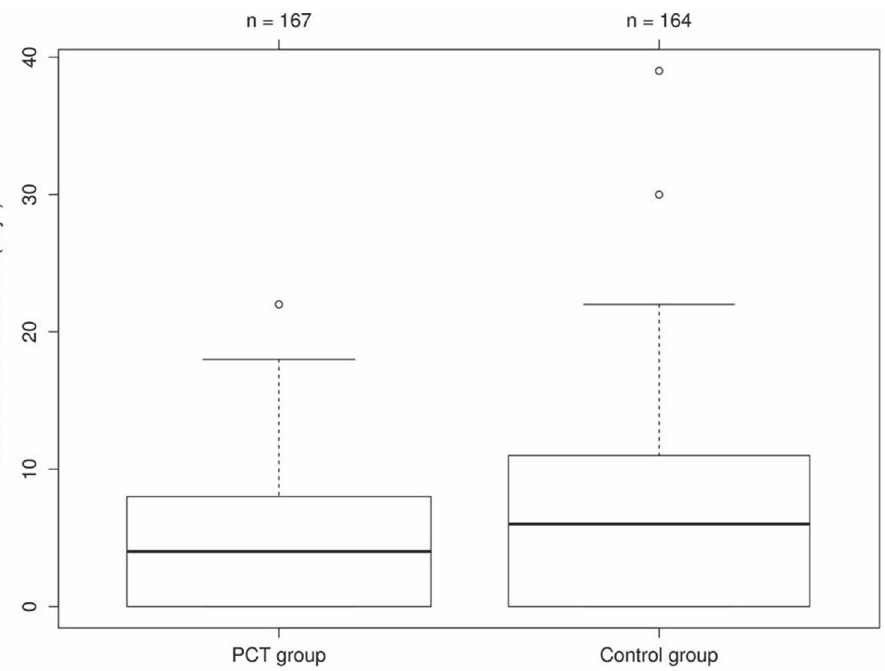
Figure 3. Duration of antibiotic treatment. Box plots of the distribution of the duration of antibiotic (AB) treatment (in days) for children and adolescents with lower respiratory tract infection (LRTI) in the procalcitonin (PCT) and control group.